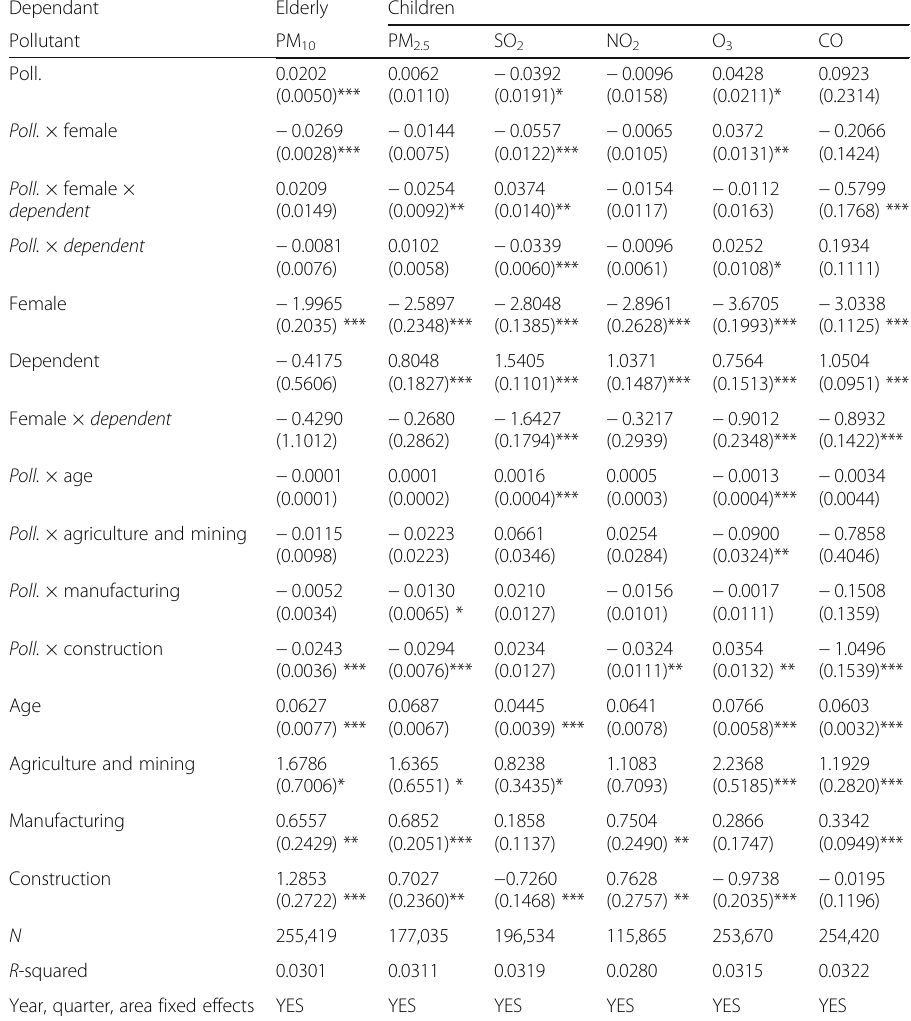
Table 4 The relationship between hours worked, gender and childcare, elderly care and other outdoor air pollutants in